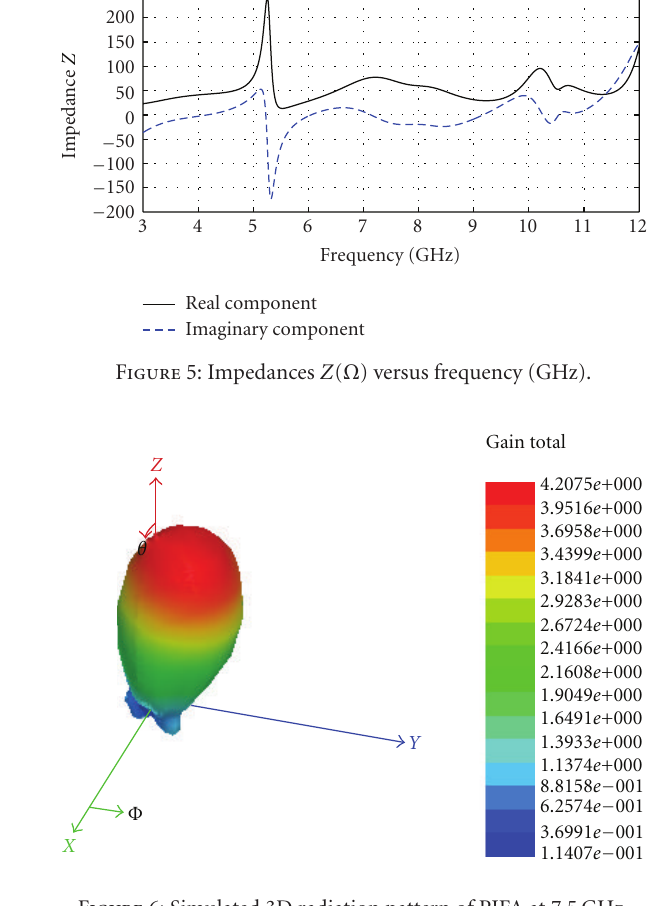
Figure 6: Simulated 3D radiation pattern of PIFA at 7.5